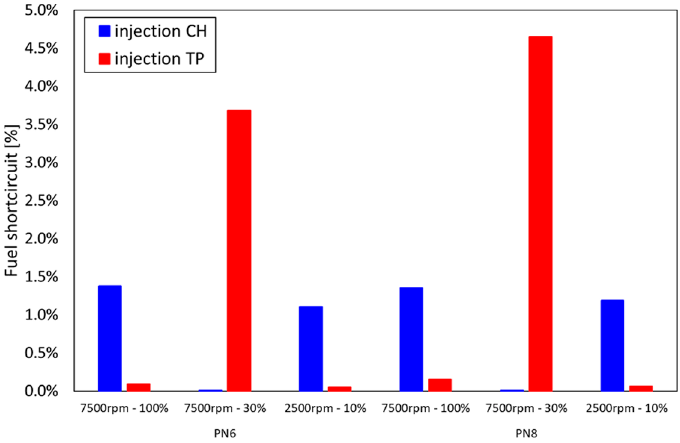
Figure 19. Fuel short circuit using both prechambers and both injection strategies.